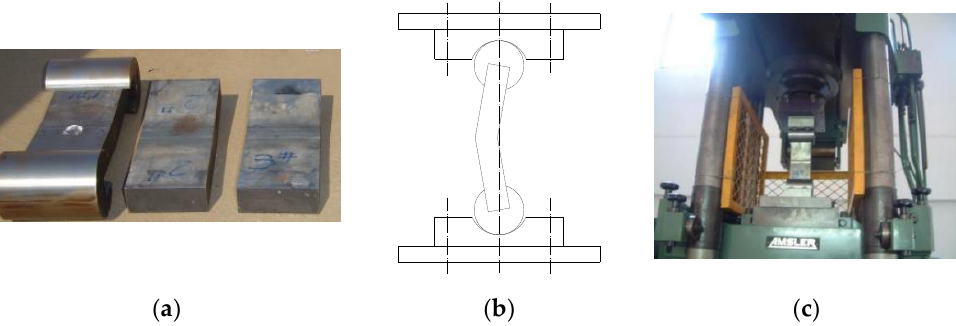
Figure 9. ( a ) The photographs of the test piece; ( b ) The diagram of the special fixture; ( c ) Test setup.